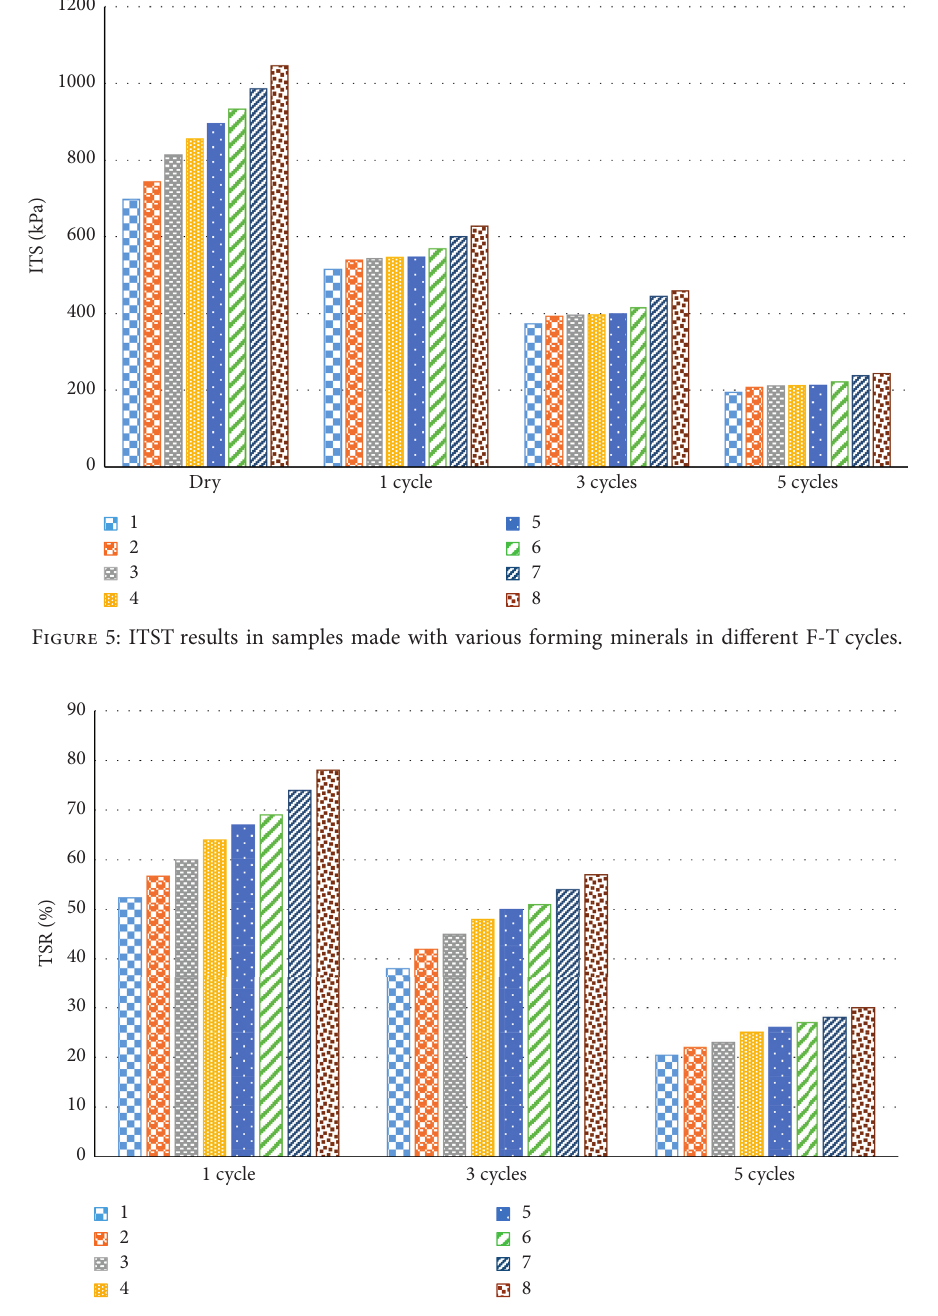
Figure 6: TSR values for samples made from aggregates of different mines. Table 7: SFE components of aggregates used (ergs/cm 2